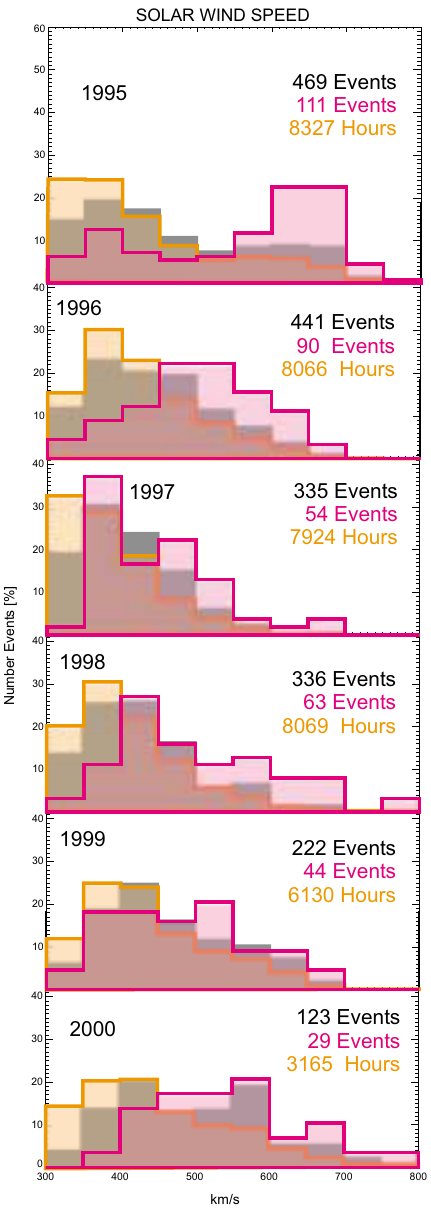
Fig. 16. Relative occurrences as functions of solar wind velocity are displayed for each year individually as marked in the panels. In each panel, the gray block-diagram presents the distribution for all events, while the distribution for the whole year is shown in orange and the separate distribution for the large amplitude events is shown in